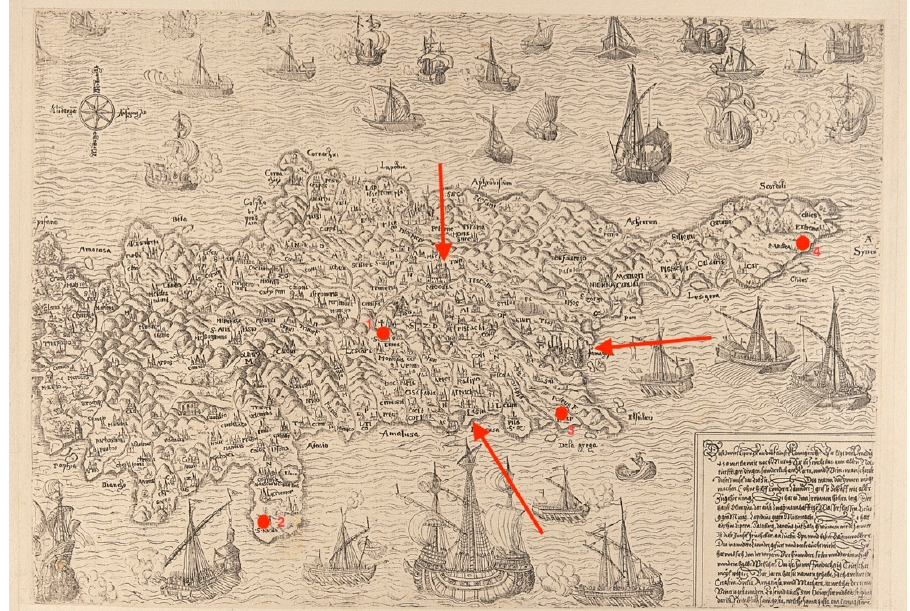
Figure 4. Map of Cyprus by Balthasar Jenichen, 1661. Bank of Cyprus Cultural Foundation, C-036. The arrows indicate the key economic centres of the “long Middle Ages”: Nicosia at the centre, Larnaka in the south, and Famagusta in the east. Sacred landmarks for sailors, traders, and pilgrims are numbered: (1) Stavrovouni; (2) Ayios Nikolaos at Akroteri; (3) Ayia Napa; and (4) Apostolos Andreas.